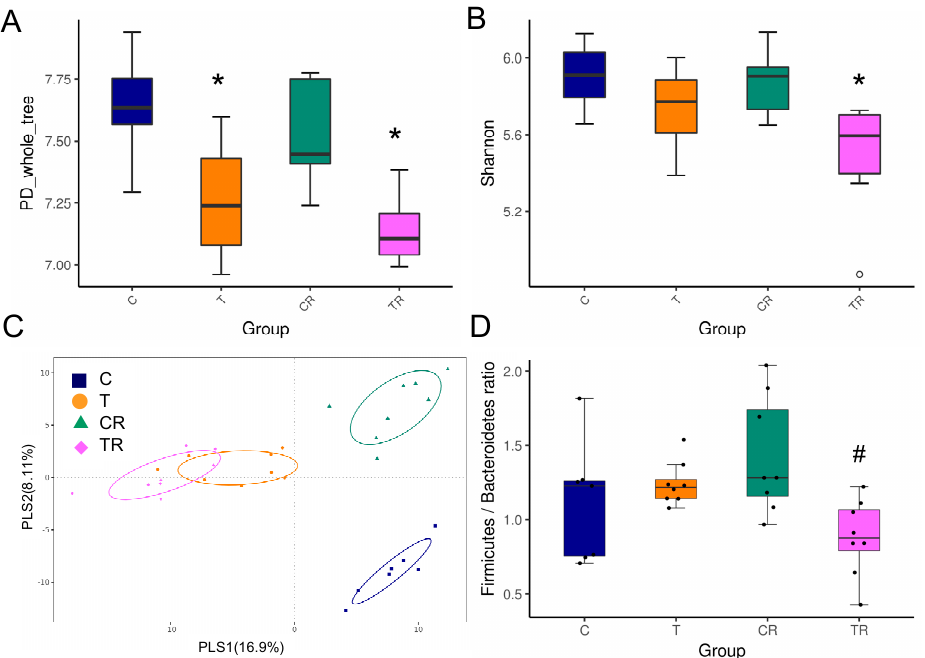
Figure 2. Effect of 2,3,7,8-tetrachlorodibenzo-p-dioxin (T) and resveratrol (R) on the gut microbiome in 12-week-old offspring. α -diversity measured by ( A ) PD whole tree and ( B ) Shannon index. ( C ) β -diversity measured by partial least squares discriminant analysis (PLS-DA). ( D ) The Firmicutes to Bacteroidetes (F/B) ratio. C = control rats received vehicle; T = rats received weekly oral dose of TCDD 200 ng/kg for four doses; CR = control rats received 50 mg/L of resveratrol in drinking water during pregnancy and lactation; TR = rats received TCDD and resveratrol treatment. * p < 0.05 vs. C; # p < 0.05 vs. T.